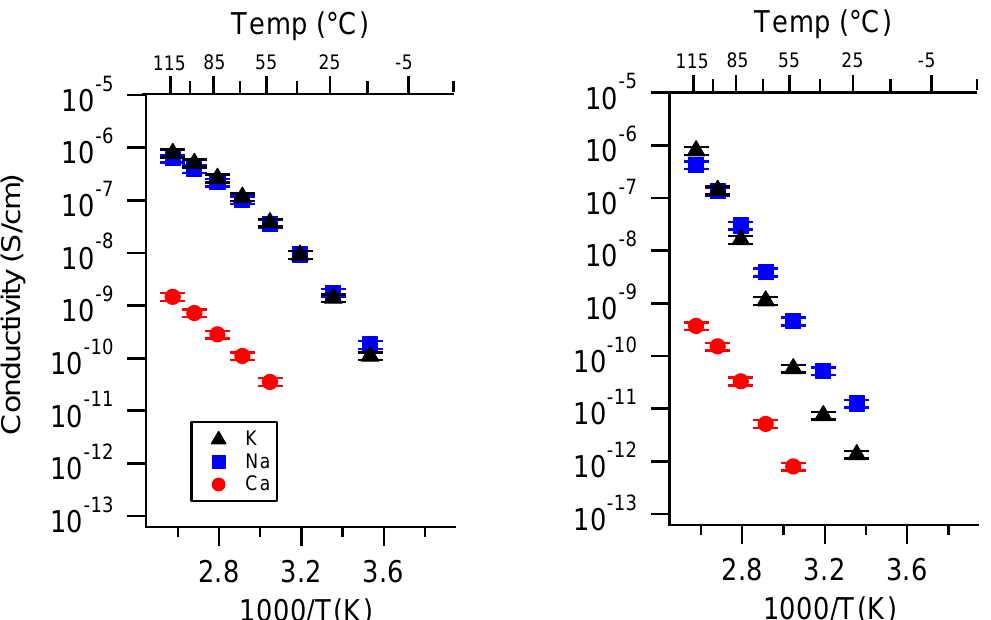
Figure A10. Conductivity as a function of cation for PEGDMA1000_low_SSM (left) and PTHFDA1000_low_STFSI (right) SIPEs dry. Temperatures ranged from − 20 ◦ C to 115 ◦ C. Note that there may be a non-negligible fraction of electronic conductivity in conditions where conductivity of less than 10 − 9 S / cm is reported.